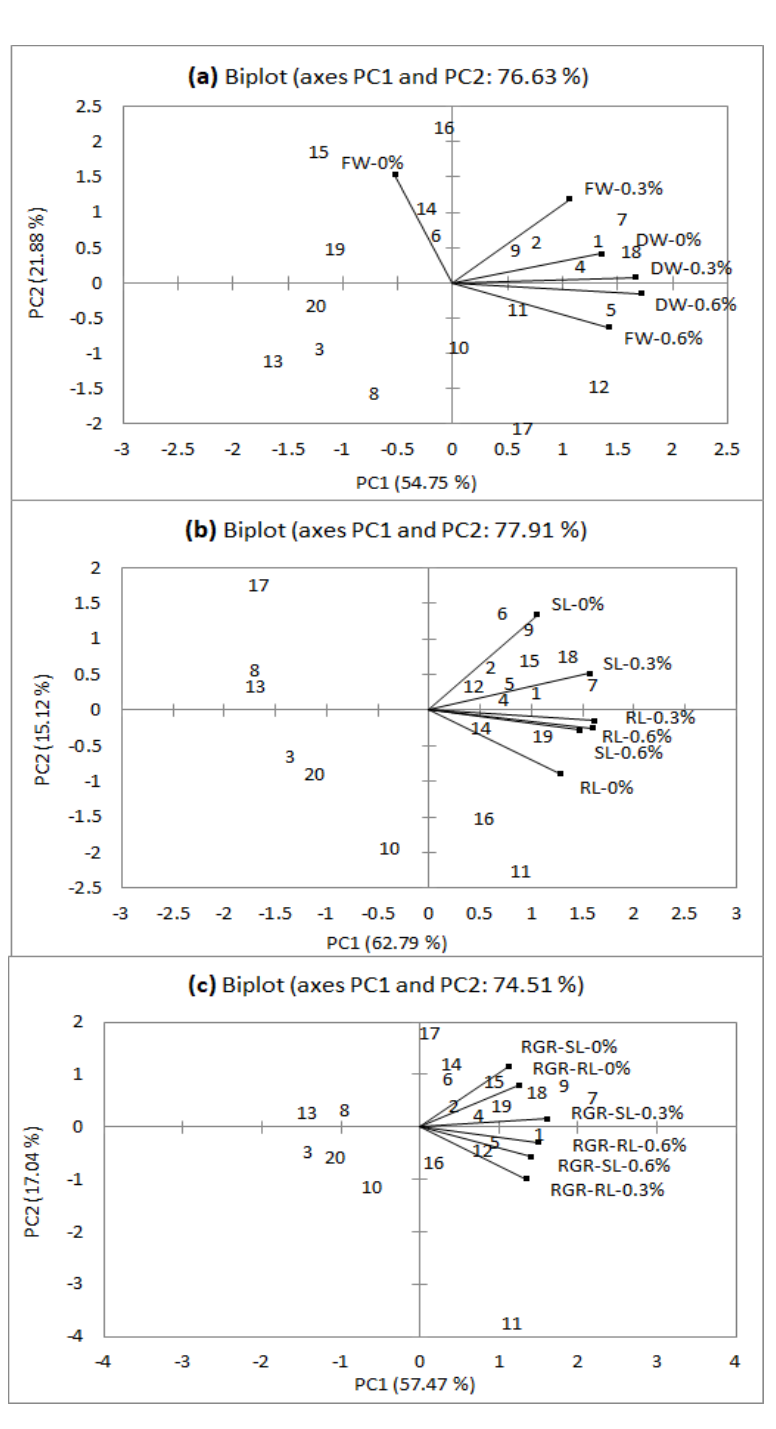
Figure 1. A “Which is best for what” vector view of genotypes by traits of growth attributes such as ( a ) FW, DW; ( b ) RL, SL; and ( c ) RGR-RL, RGR-SL, under varying water deficit conditions. See Table 1 for codes of the genotypes.